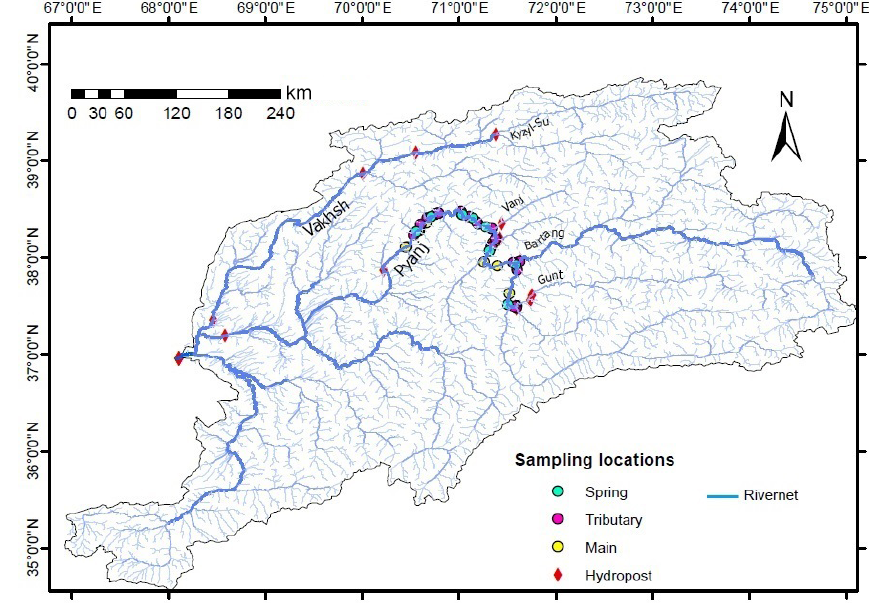
Figure 2. Maps of Pyanj River and tributaries basins.